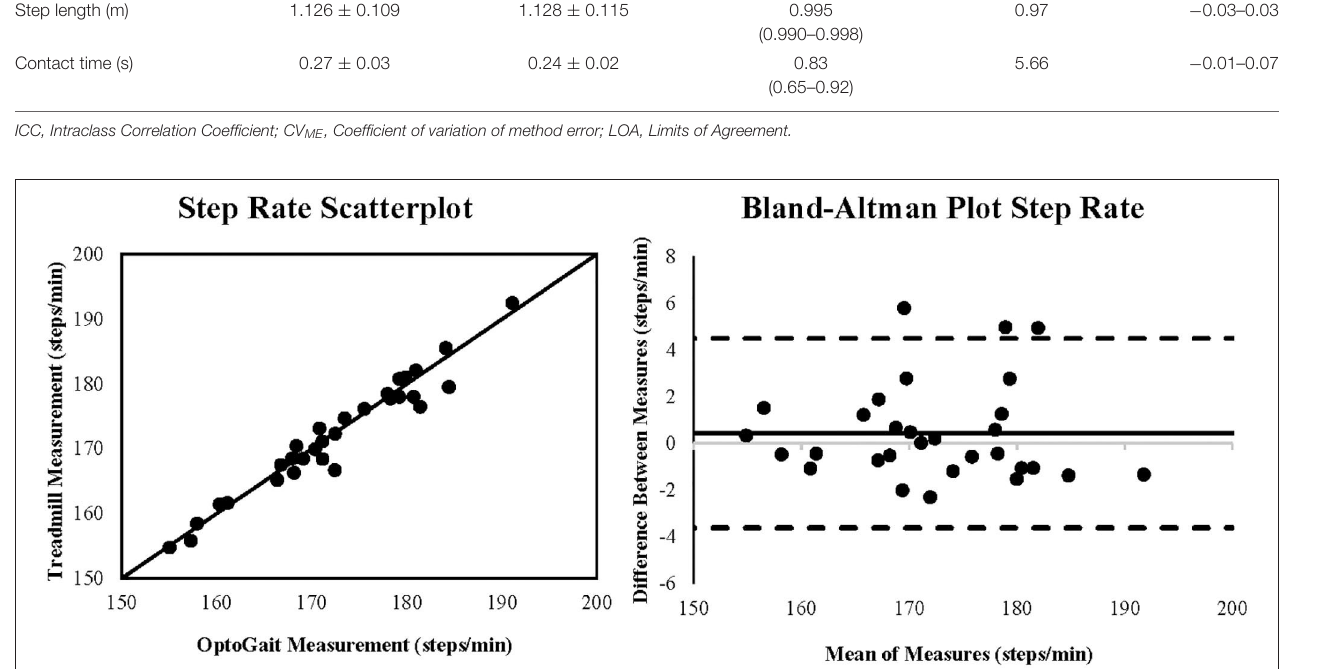
agreement (LOA) using a Bland-Altman plot (Bland and Altman, 1986; Giavarina,